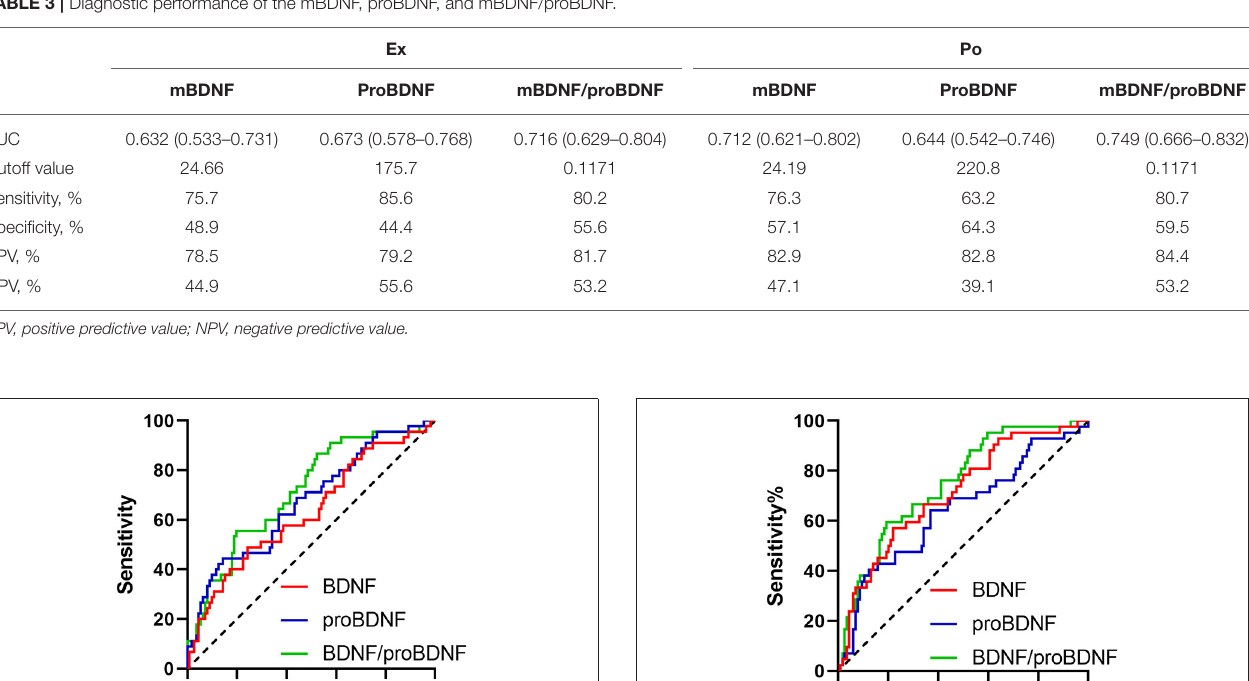
TABLE 3 | Diagnostic performance of the mBDNF, proBDNF, and mBDNF/proBDNF.